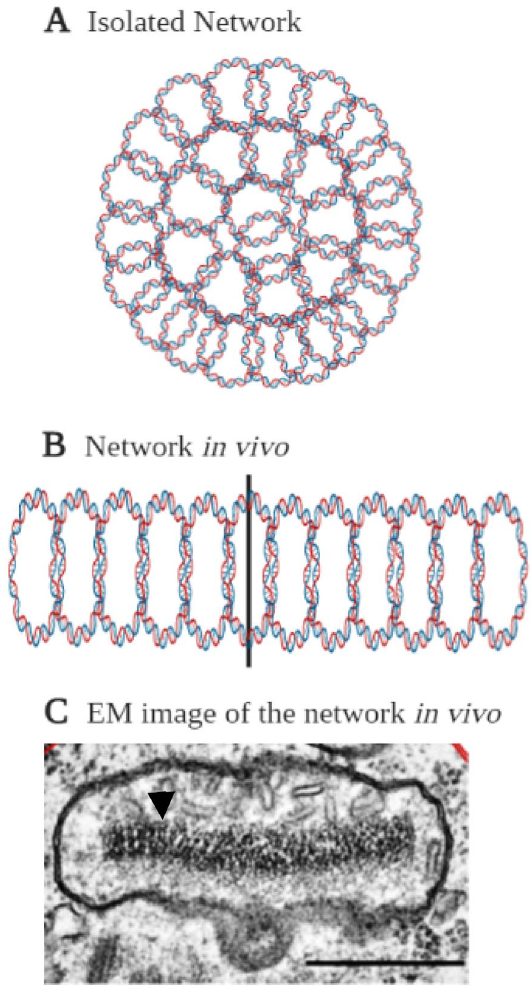
Figure 1. Organization of the kDNA network. (A) Diagram of an isolated, uncondensed kDNA network, in which minicircles lie flat in the plane. (B,C) Condensed kDNA networks in vivo. (B) Diagram of a section of kDNA network, condensed in vivo into a disc-shape structure of 1.0 × 0.4 mm, in which the interlocked minicircles are stretched out and stand side by side. The vertical bar represents the axis of the disc. The height of the disc is approximately one half the circumference of a minicircle (0.4 µm). (C) An electron micrograph of a thin section of a T. brucei cell, focusing on its single mitochondrion. The black arrowhead marks the condensed kDNA disc, within the mitochondrial matrix. Bar, 500 nm. (A,B) were created in BioRender (https ://biore nder.